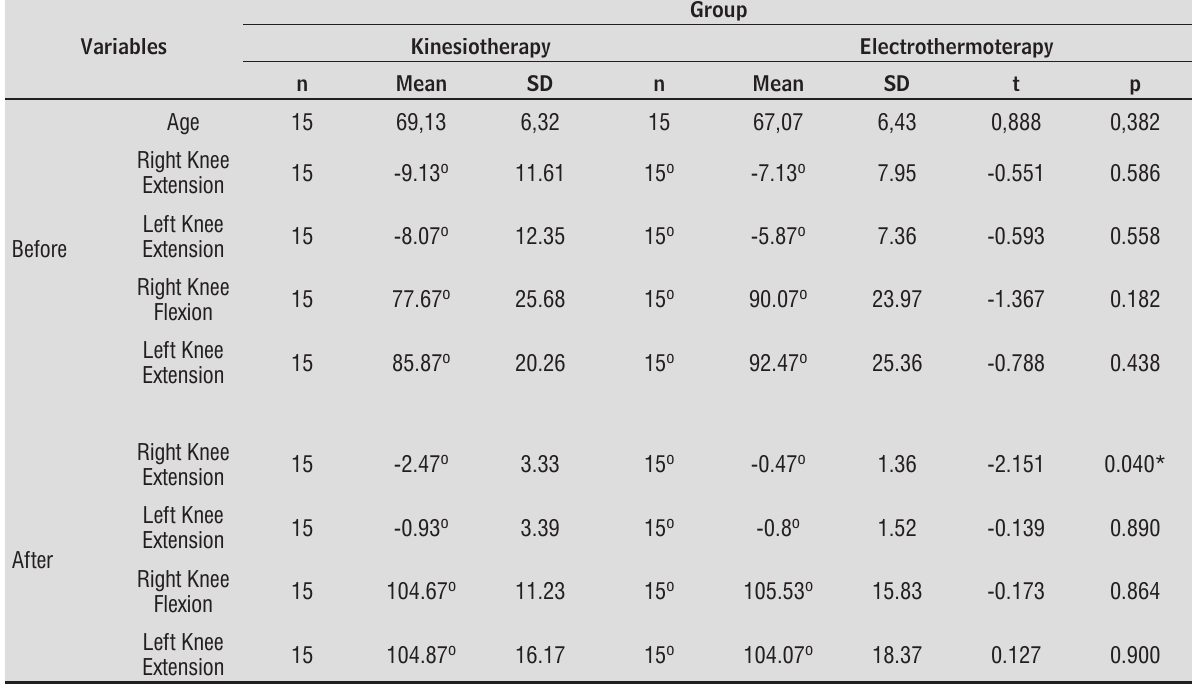
Table 2 - Comparison of range of motion values in bilateral movements of extension and flexion of the knee before and after the treatment with methods Kinesiotherapy (GI) and Electrothermoterapy (GII) in 30 elderly women. São Luís, MA,